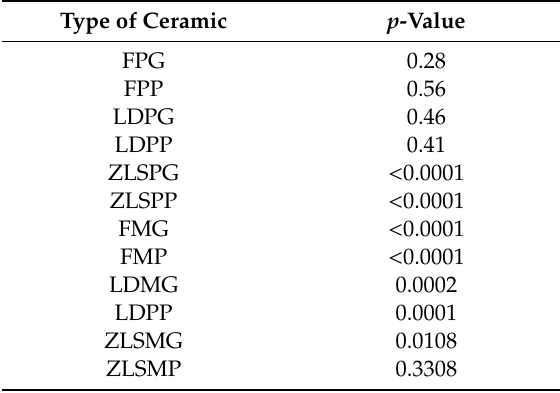
Table 6. Mean values for OP